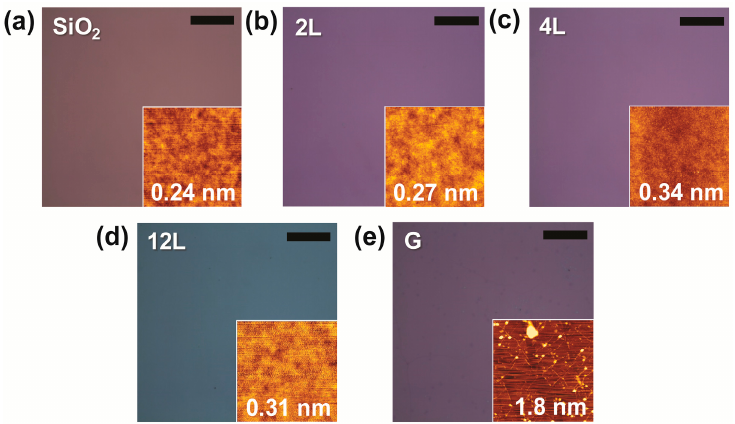
Figure 1. Optical and AFM images (insets, 4 µm × 4 µm scan) of ( a ) a bare SiO 2 /Si sample, and ( b ) 2L MoS 2 , ( c ) 4L MoS 2 , ( d ) 12L MoS 2 , and ( e ) 1L graphene each on a SiO 2 /Si substrate. Texts in the insets indicate RMS surface roughness. Scale bars, 20 µm.